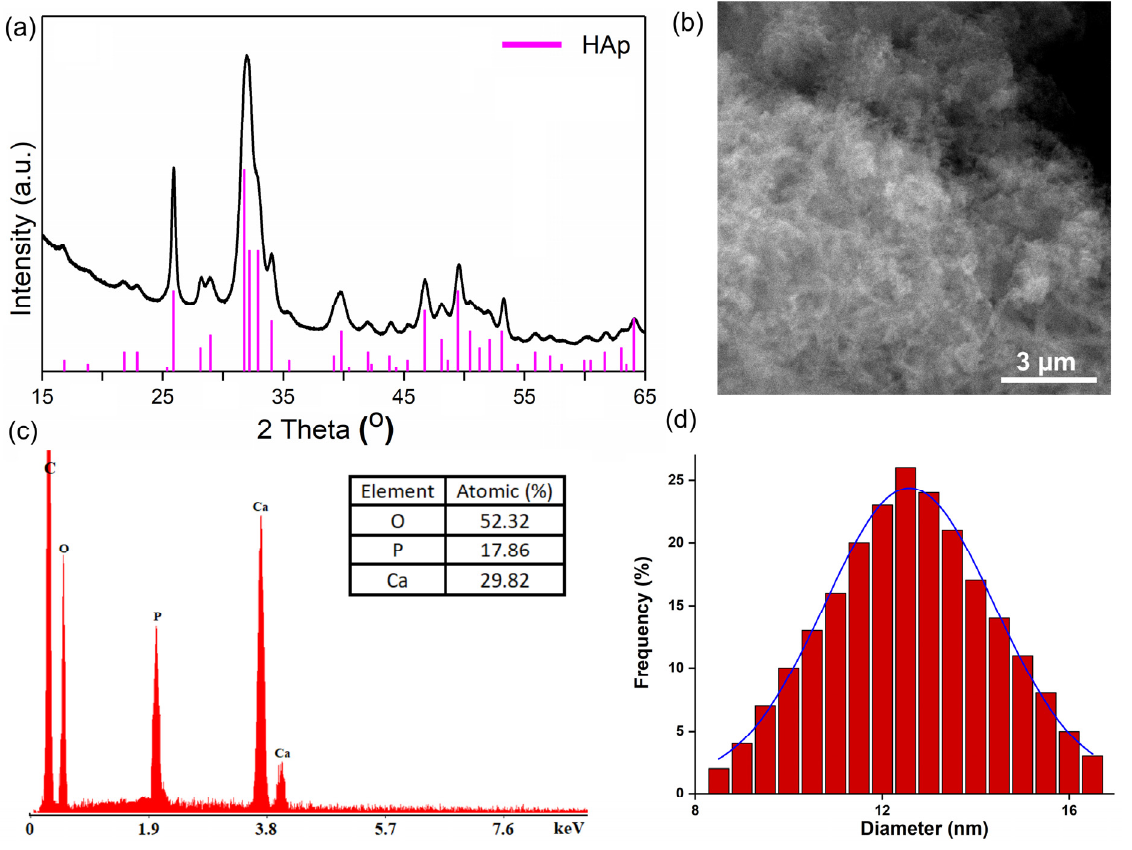
Figure 1. XRD patterns of synthesized powder ( a ); SEM image of HAp powder ( b ); EDX spectra of HAp ( c ) and SEM particle size distribution ( d ).